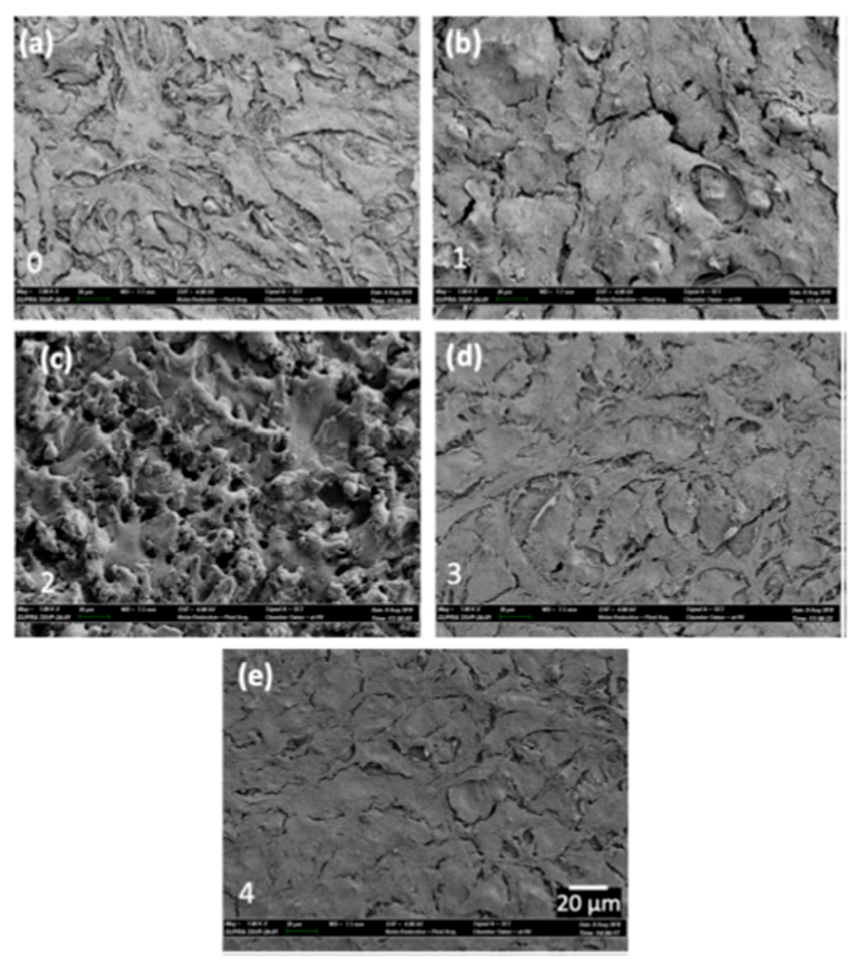
Figure 20. SEM micrographs showing the attachment of MG-63 cells on ( a ) conventionally machined surface and ( b – e ) samples prepared by WEDM by different parameters [43]. (With kind permission from Elsevier).